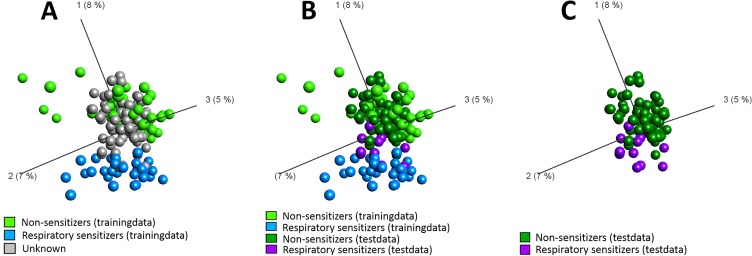
Visual classification of independent test compounds using GARD Respiratory Prediction Signature, GRPS.(A) The PCA space was constructed from the three first PCA components from the panel of reference chemicals (n = 103) used for biomarker signature identification, using the 389 genes of GRPS as input into the unsupervised representation. Each of the chemicals in the test dataset (n = 92) were plotted into the PCA space without allowing the compounds to influence PCA components. (B) Samples in the test dataset was colored according to sensitizing properties as either respiratory sensitizers (dark blue) or non-respiratory sensitizers (dark green). A separation between respiratory sensitizers and non-respiratory sensitizers can be seen along the first PCA component for both the training data and the test data. (C) The training dataset has been removed in order to obtain a clear view of the training dataset.